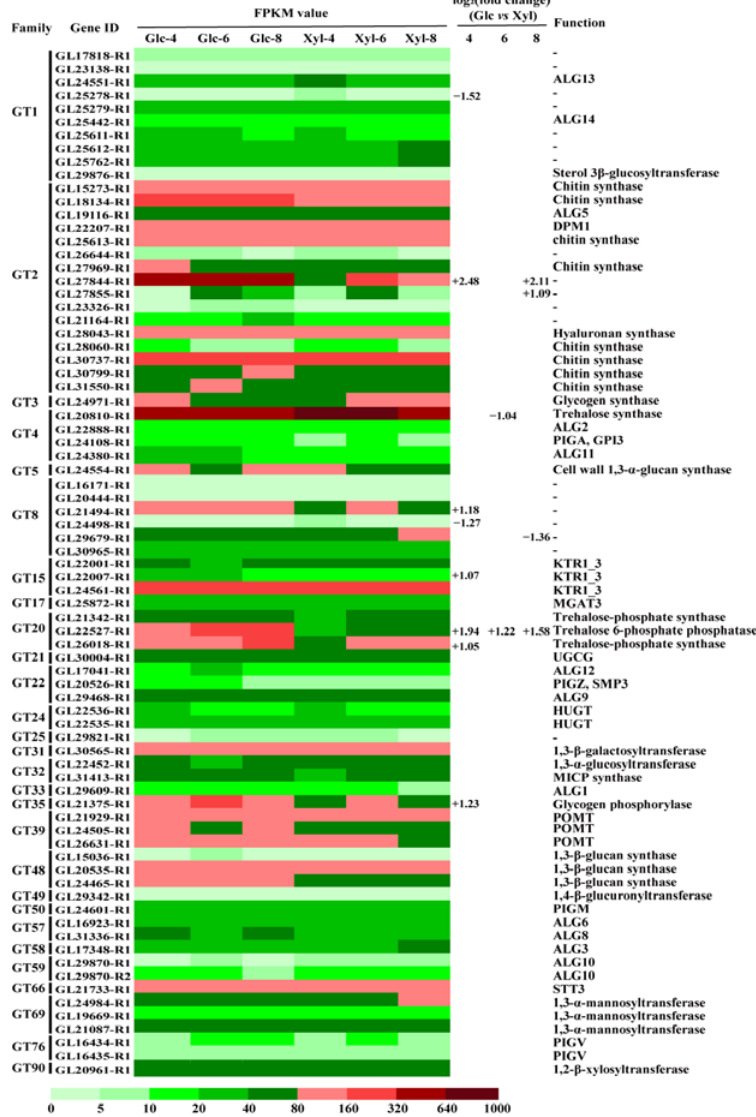
Figure 3. FPKM value, differentially expressed genes, and function of glycosyl transferase family of genes in G. lucidum on days 4, 6, and 8. Glc: glucose; Xyl: xylose. +: upregulated; − : downregulated.